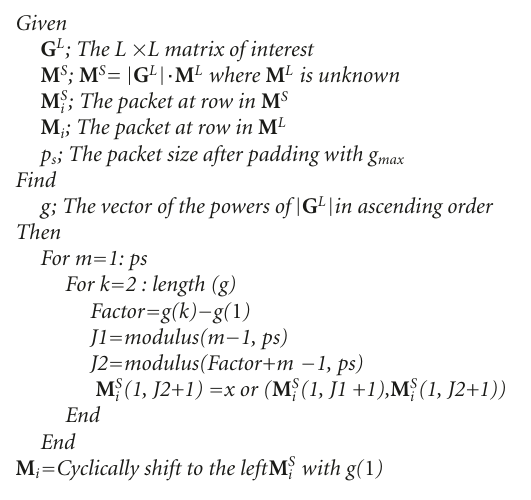
Algorithm 2: A routine to extract M L from the product of M L with | G L |